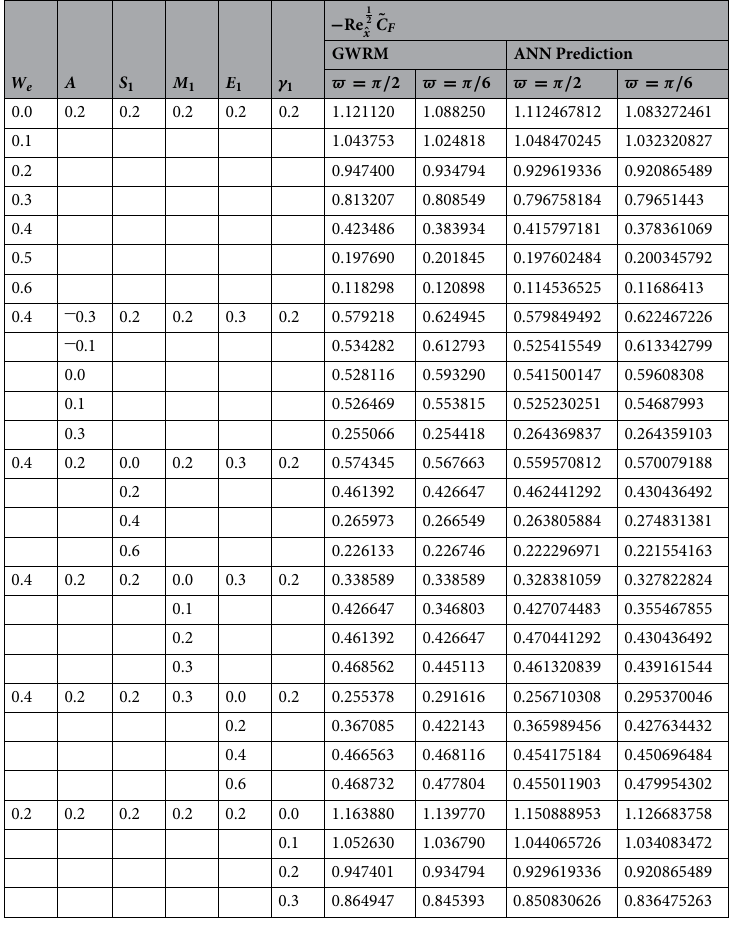
1 C F for different values of physical 2 x ˜ ˆ